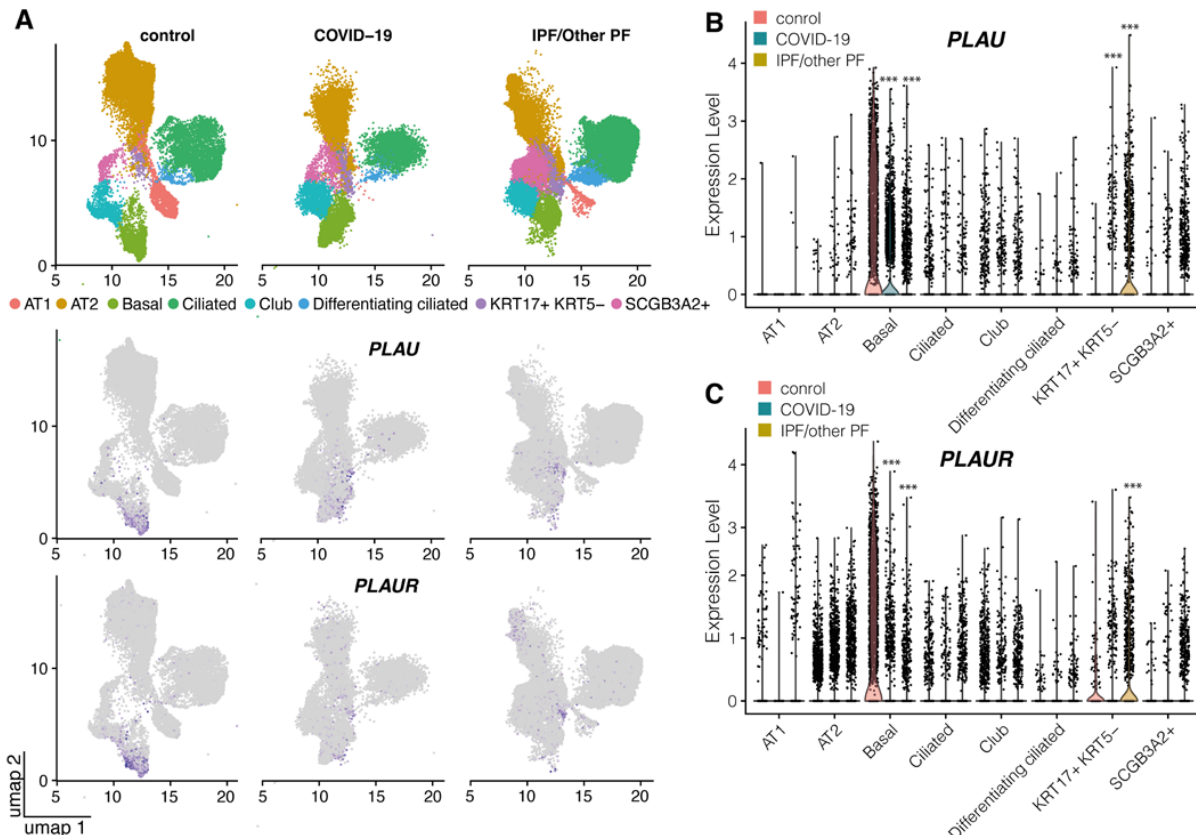
Figure 1. PLAU and PLAUR expression in epithelial cells of control, COVID-19 and pulmonary fibrosis (PF) lung samples: ( A ) Uniform Manifold Approximation and Projection (UMAP) embedding of jointly analyzed single-cell transcriptomes annotated by cell type (color) and disease status. Lung tissue transcriptomes of patients with COVID-19-associated pneumonia, PF and control lung samples from healthy donors, reported in Habermann et al. and Bharat et al. (GSE158127, GSE135893 [35,36]) were analyzed. Normalized expression levels of PLAU ( B ) and PLAUR ( C ) grouped by different types of epithelial cells and disease status (control, COVID-19 and PF from left to right); statistics were calculated only for cell types with the median normalized expression value > 0 with the exception of KRT17+ KRT5- cells, where the median expression value equaled to 0, but a subpopulation of PLAU - and PLAUR -positive cells still existed. *** p adjusted < 0.0001 as assessed by false discovery rate (FDR). AT1 and AT2, alveolar type I and type II cells; IPF/other PF, idiopathic pulmonary fibrosis and other pulmonary fibrosis; umap, Uniform Manifold Approximation and